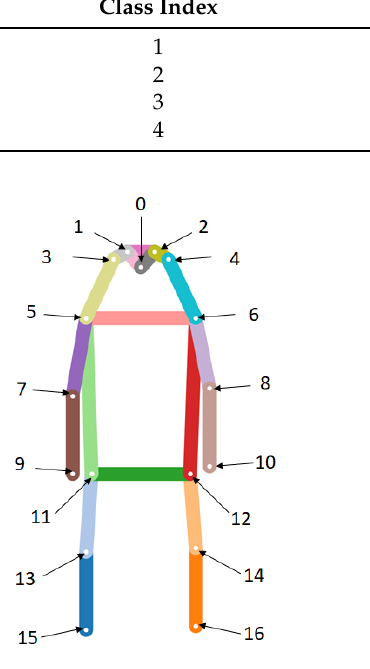
Figure 2. The list of skeleton names and indices from OpenPifPaf [32] with their